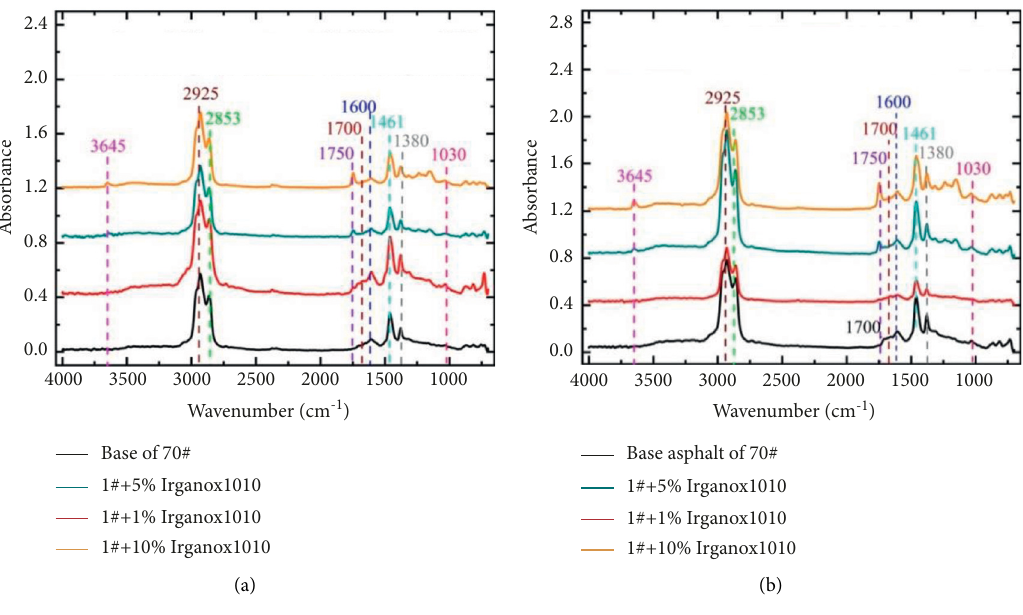
Figure 12: FTIR spectra of asphalt 1# (a) before aging (b) after